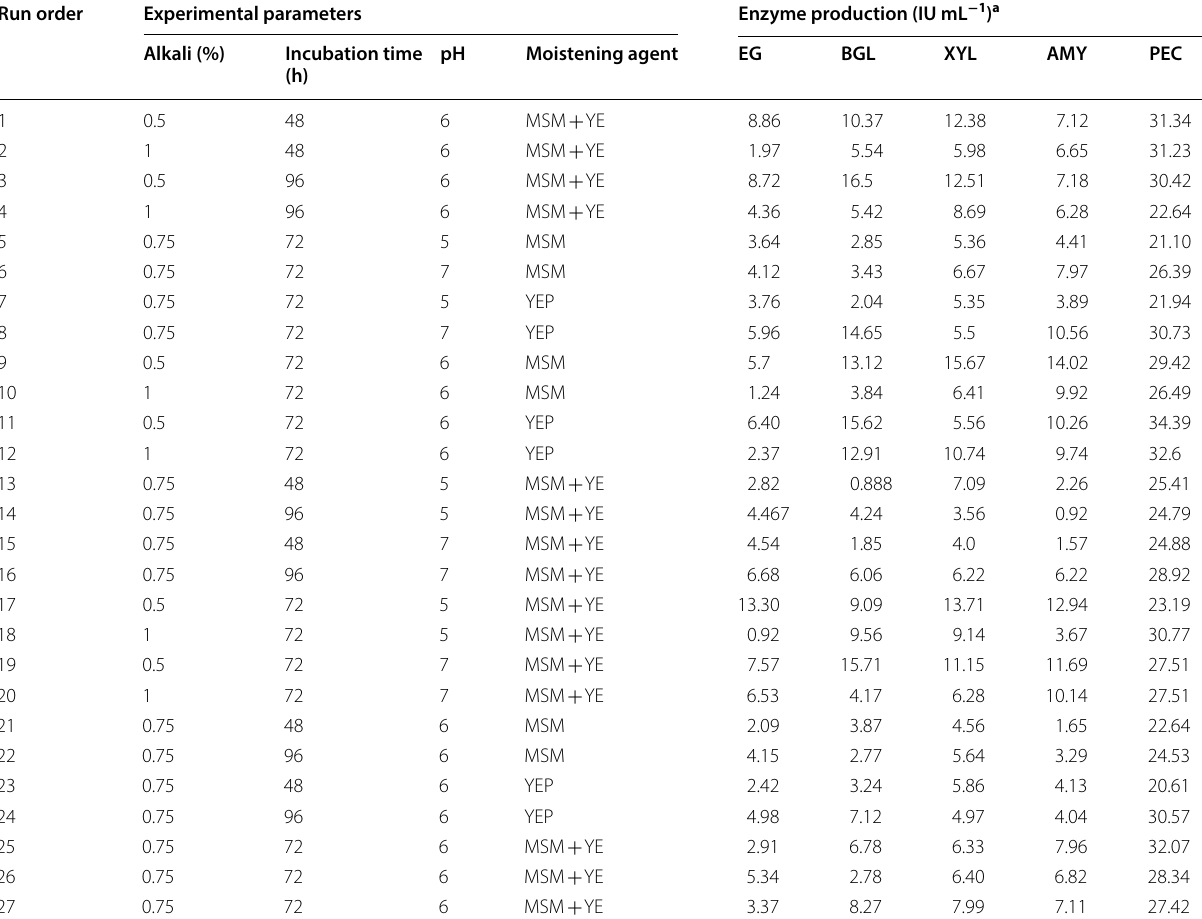
Table 4 Box–Behnken design matrix for production of endoglucanase (EG), β-glucosidase (BGL), xylanase